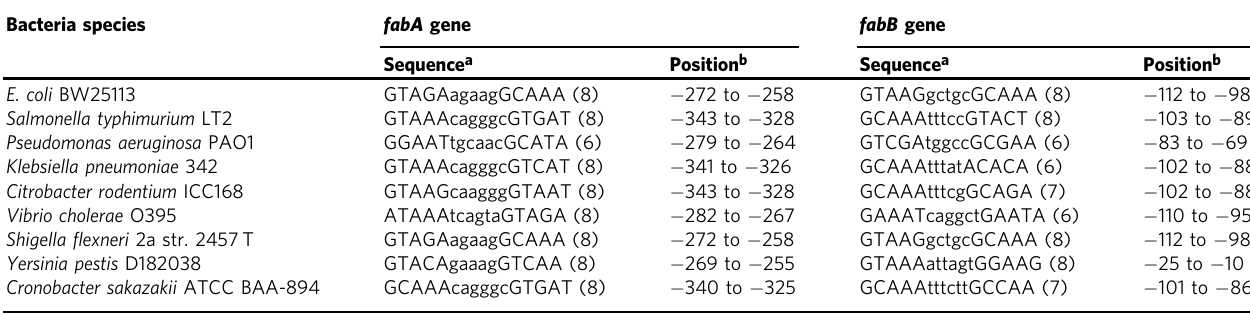
Table 1 Putative CpxR box of fabA and fabB genes from Gram − bacteria (The genome sequences of various bacteria used in this table are under the accession numbers CP009273, NC_003197, NC_002516, NC_011283, NC_013716, CP001235, NC_004741, CP001589, and NC_009778,